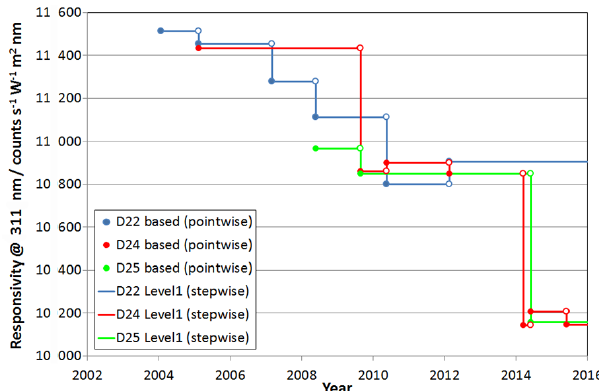
Figure 6. Responsivity of Brewer #037 as determined on the basis of the newly recalibrated primary standard lamps D22, D24, and D25 (discrete values) and the corresponding stepwise constant re- sponsivity of type Level1 used for near real-time processing of solar UV irradiance spectra.